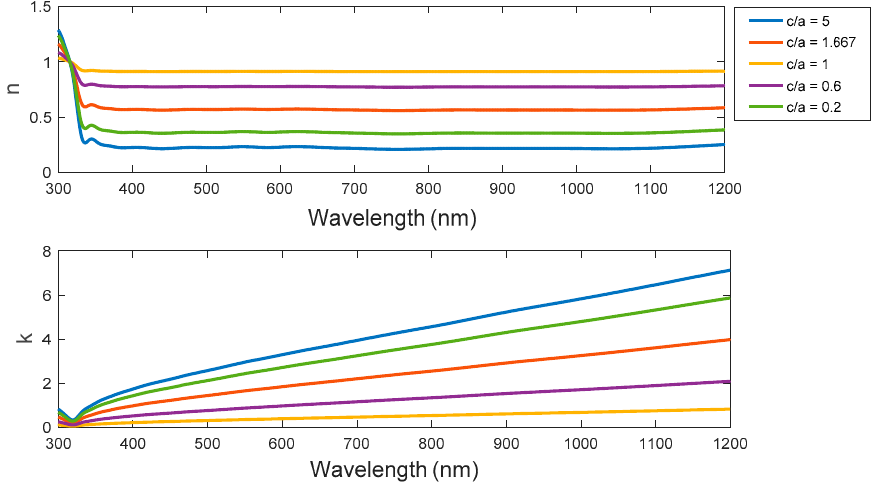
Figure 3. The real part of RI ( 𝑛 ) and the extinction coefficient ( 𝑘 ) for the ellipsoid, sphere, and spheroid at different aspect ratios.